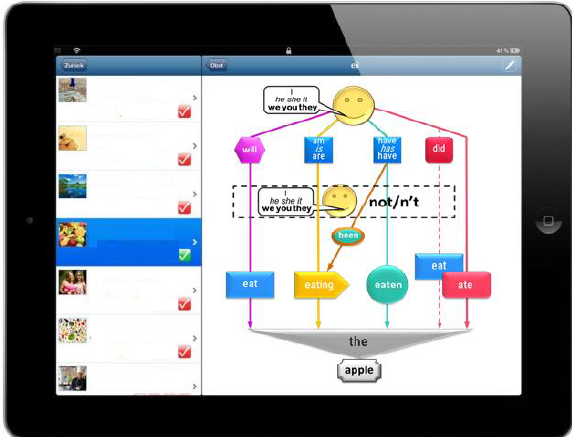
Fig. 13. Interface of the system in mobile